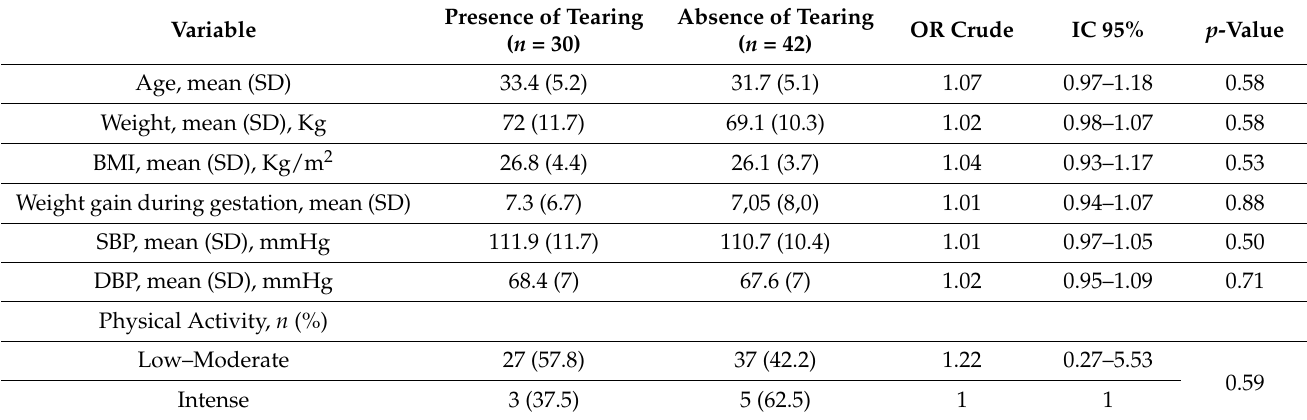
Table 3. Characteristics of the sample of pregnant women participants by presence or absence of tearing and crude logistic regression 1